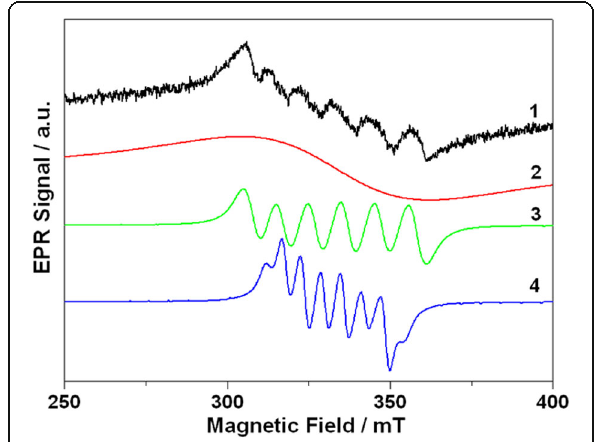
Fig. 4 EPR spectrum of Cd 0.97 Mn 0.03 Te-alloyed QDs and its deconvolution: 1 — experimental spectrum; 2 — Gaussian curve with peak-to-peak linewidth 50 mT. 3 — sextet with splitting of ~ 10 mT.